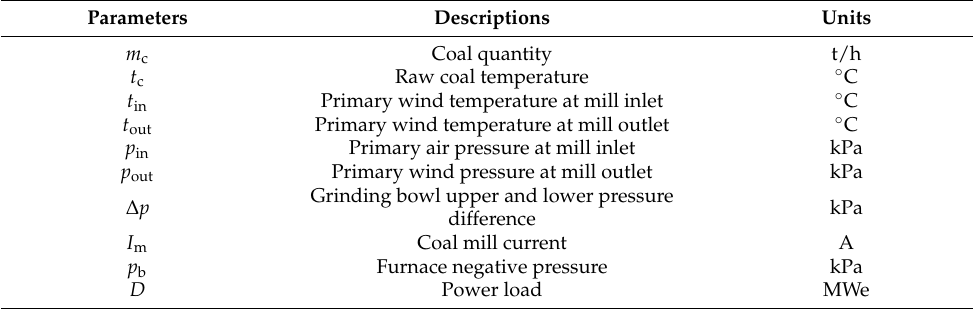
Table 3. Main parameters of coal mill in the case study of this